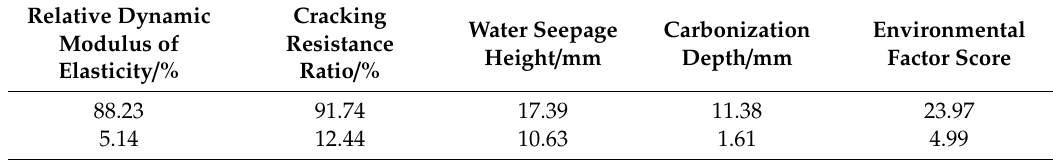
Table 5. Mean and standard deviation of initial